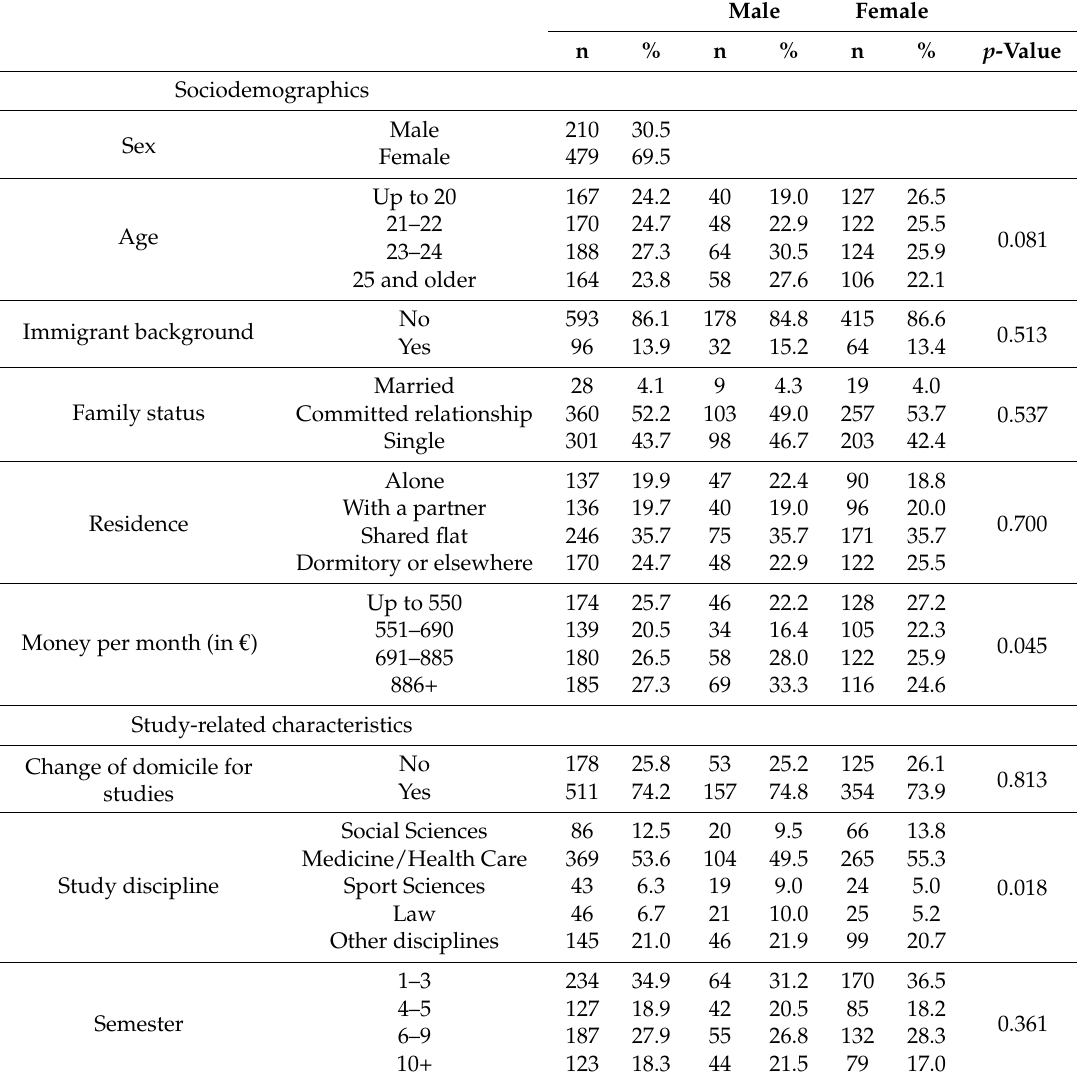
Table 1. Characteristics of participating university students in